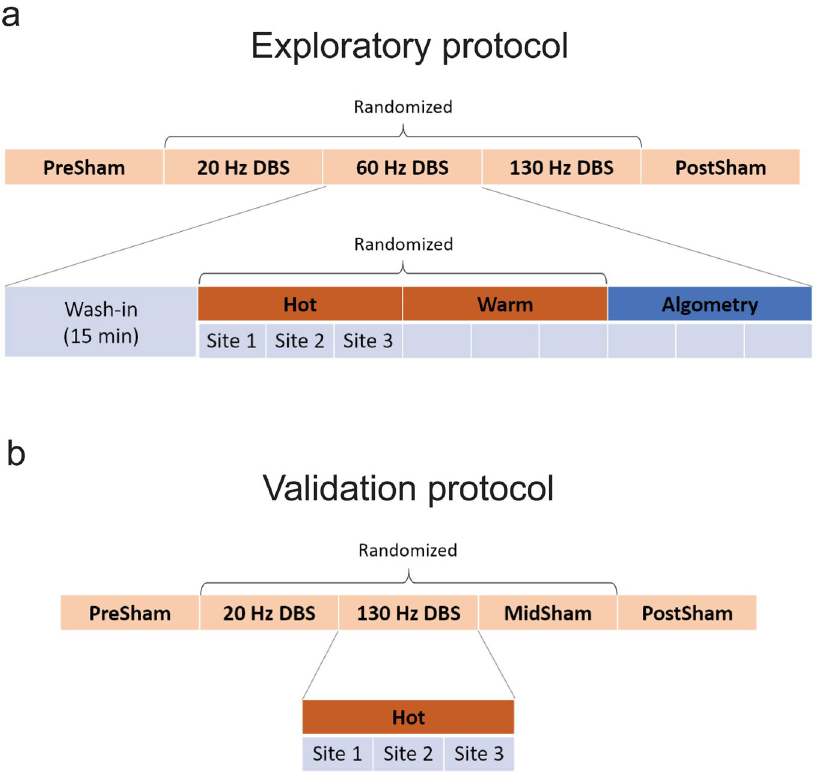
Figure 6. Experimental protocols. ( a ) Protocol for initial exploratory trials. ( b ) Protocol for validation trials including additional sham trial. Order of randomized DBS settings were hidden from both subject and experimenter. Order of randomized thermal stimuli were hidden from